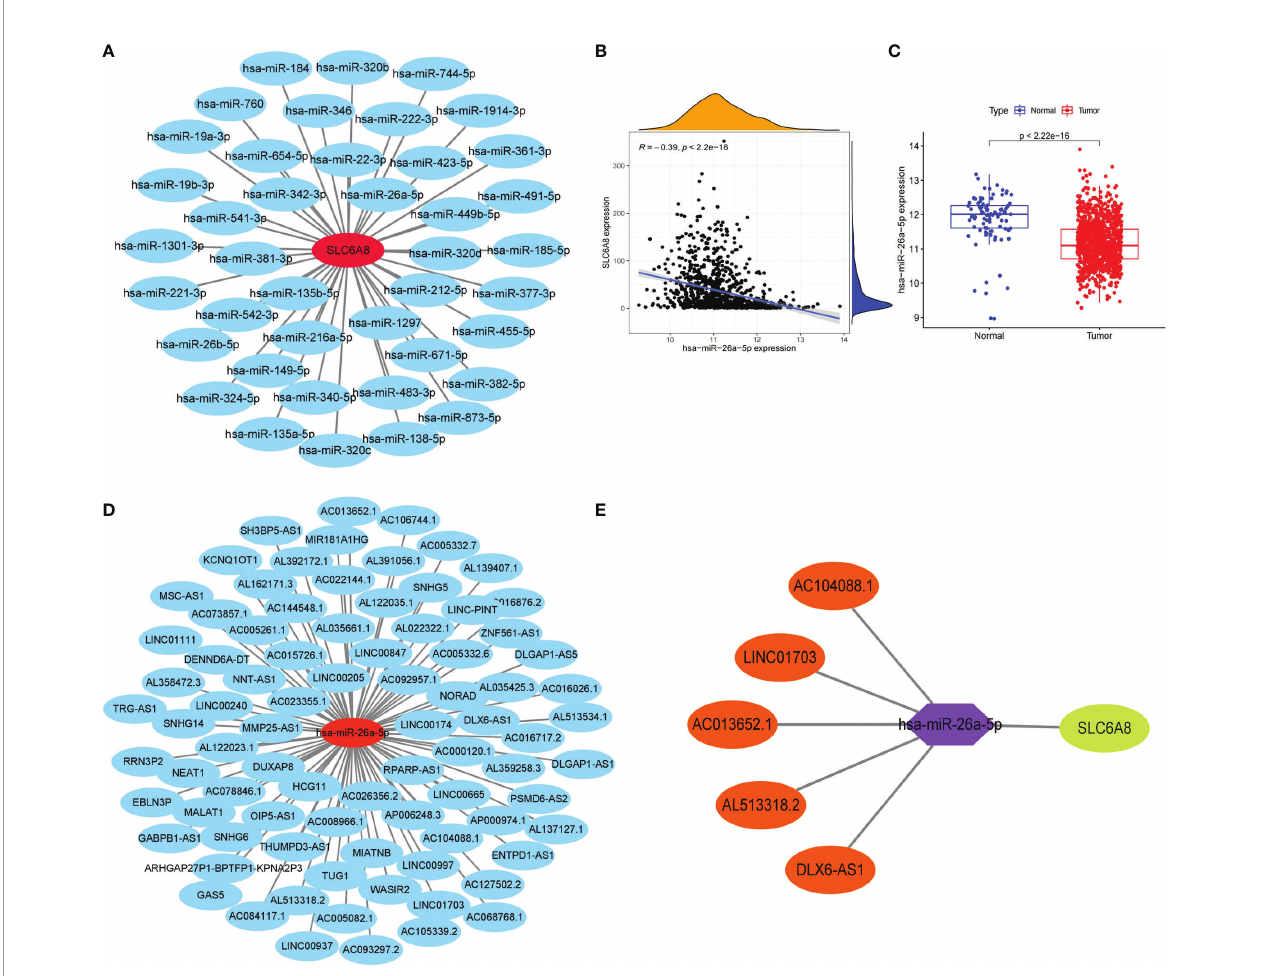
FIGURE 3 | Construction of the lncRNA-miRNA-mRNA triple regulatory network for SLC6A8 overexpression in NSCLC. (A) Starbase database of miRNAs targeting binding to SLC6A 8 in NSCLC (B, C) Targeted miRNAs associated with SLC6A8 expression in a triple-regulatory network (cor<-0.3, P-value < 0.001, logFC<0. diffP-value < 0.05 ) (D) Starbase database of IncRNAs targeting binding to hsa-miR-26a-5p in NSCLC. (E) The ceRNA regulatory network of SLC6A8 overt expression in